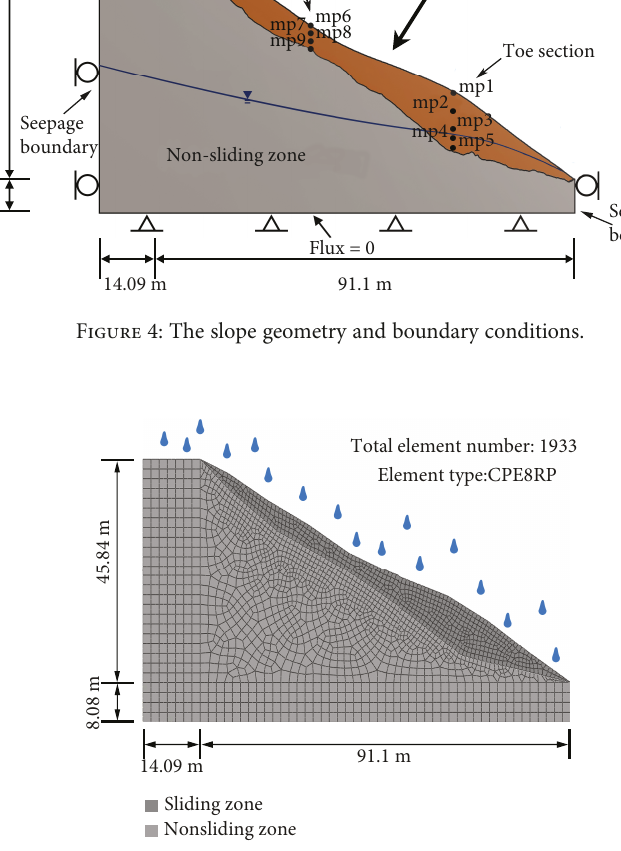
Figure 5: The fi nite element meshes used in